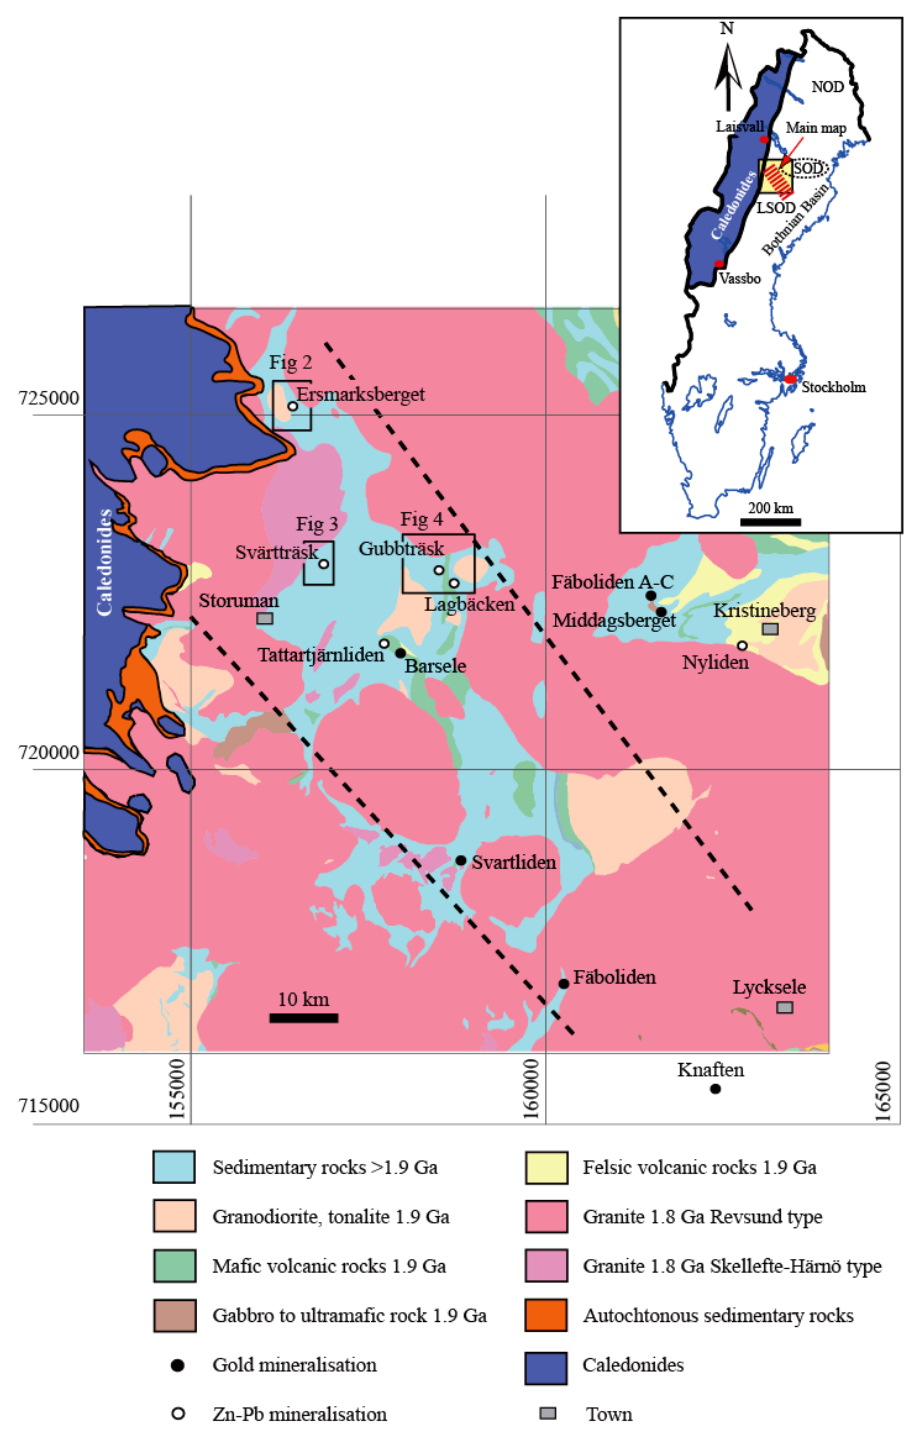
Figure 1 . Simplified geological map of the Lycksele-Storuman Ore District (LSOD). The LSOD is approximately confined to the area between the dashed lines. The study areas are indicated by small boxes (Figures 2–4). This figure and Figures 2a, 3 and 4 are modified after the digital map databases of the Geological Survey of Sweden (SGU). Coordinates refer to the Swedish National Grid, RT 90. Inset map: Location of LSOD in northern Sweden. SOD = Skellefte Ore District. NOD = Norrbotten Ore